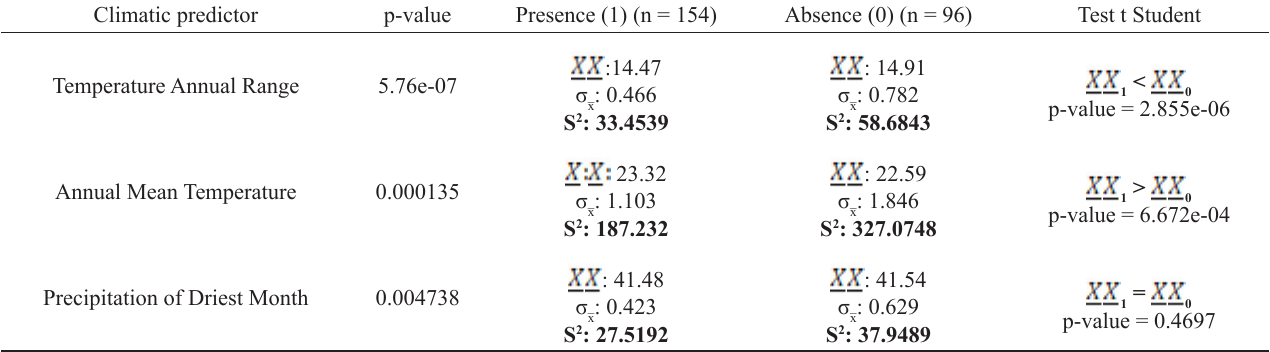
Fig 1 . Data sampling points of this study and current geographic distribution of D. lucida , according to ICMBio